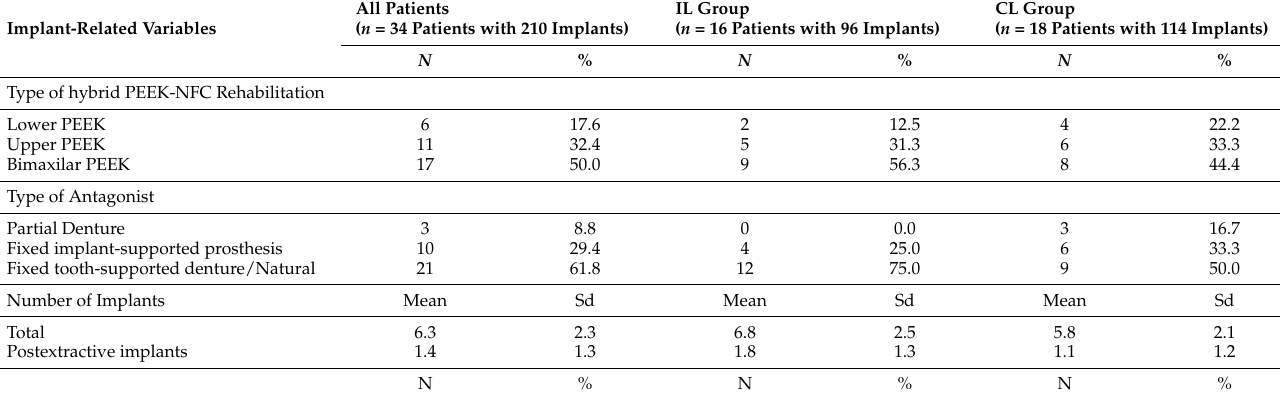
Table 3. Distribution of the type of rehabilitation among patients and number of implants per patient ( n = 34). Implant-Related